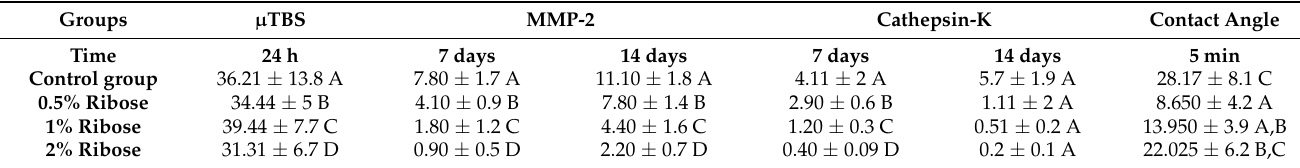
Table 2. Mean ± SD of micro-tensile bond strength ( µ TBS) in MPa in different groups after 24 h. In the rows, groups identified by different symbols are statistically different ( p < 0.05). µ TBS: micro-tensile bond strength. Mean ± SD for inhibition of MMP-2 and cathepsin-K activities 7 and 14 days. Comparison of MMP-2 and cathepsin-K activities (ng/mL) obtained with Human MMP-2 and cathepsin-K ELISA Kit system. Groups identified by different superscripts letter are statistically significantly different within each column. Mean ± SD of contact angle in different groups after treating with different concentrations of RB. Groups identified by different superscripts capital letters for different groups (shows differences between variables) are statistically different within each